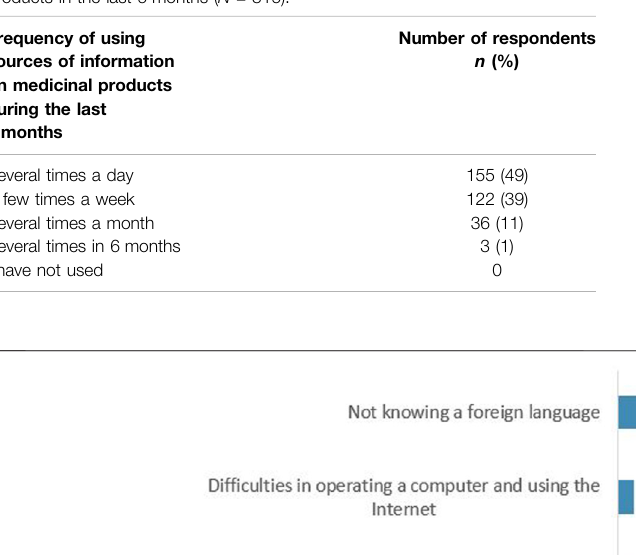
Frontiers in Pharmacology |